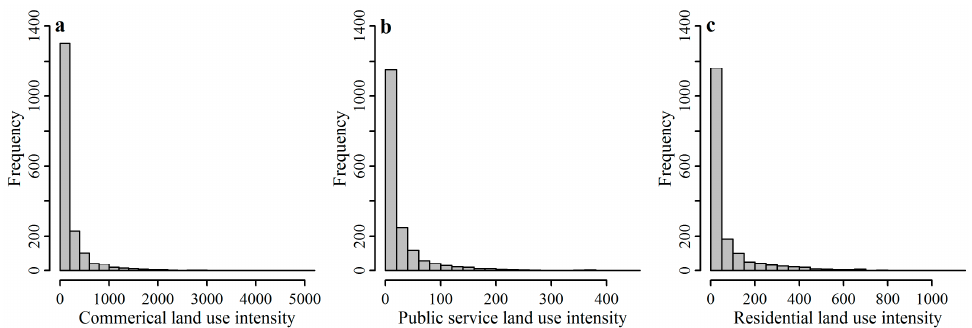
Figure 8. Frequency distributions of land use intensities using kernel density estimation (KDE) in a 1 1 km grid. ( a ) Commercial land use intensity, ( b ) public service land use intensity, ( c ) residential land